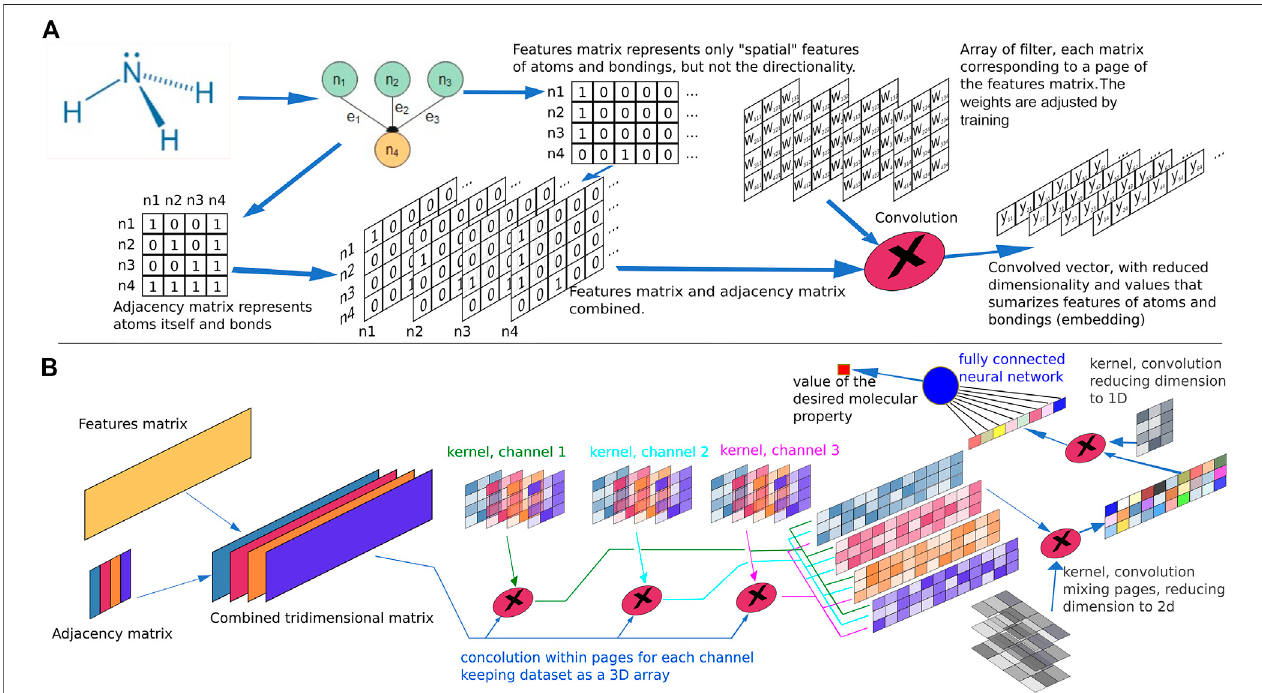
FIGURE 7 | Molecular property representation. (A) Example of an atomic feature matrix and an adjacency matrix for ammonia. The elements i, j in the adjacency matrix are representations of the connection between atoms i and j. A combination of the feature and adjacency matrix is performed by column wise multiplication, resulting in a 3D array. Each atomic bond corresponds to a “ page ” in the array. A fi lter (kernel) corresponding to a 3D matrix with the same number of pages as the combined data set feature-adjacency is applied to the matrix through a scalar product. The fi lter elements, when inserted in a neural network comprise weight parameters for the connectionsand its values are adjusted bytraining, de fi ning the fi lter characteristics in an optimized manner. The offset of the fi lter with respect to the data set is swept to cover the entire indices range. The result of the convolution operation in this example is a 2D array with four rows and N-2 columns, where N is the number of columns in the feature matrix. (B) Example of a hypothetical neural network used to calculate the value of a property of a given molecule. Several convolution layersarechainedtoperformtheembeddingofthedatarepresentingtheatomicfeaturesandtheatomicbonding,theresultbeinga1Dvectorwhichisfurthersubmitted toafullyconnectedneuralnetwork.Theoutput ofthisnetworkisthedesired parameter. Thetrainingalgorithmadjusts theparameters ofallkernel fi ltersand theweights of the output neural network, until the error of the predictions compared to the training set are